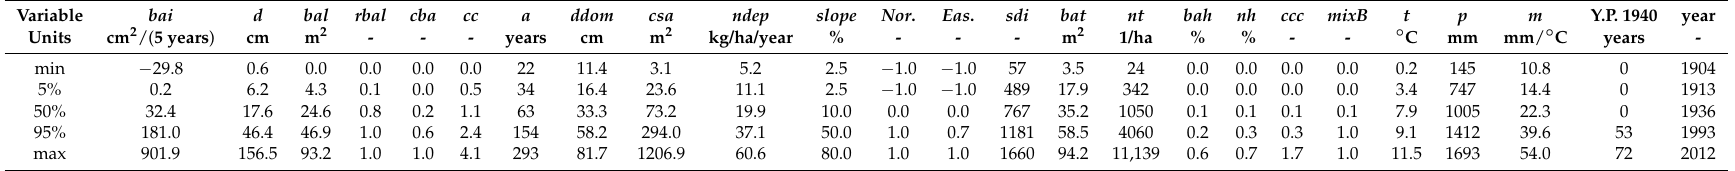
Table 1. Overview and quantiles of the data. The following abbreviations were used: Nor. = northness; Eas. = eastness; Y.P. 1940 = years past 1940. Variable